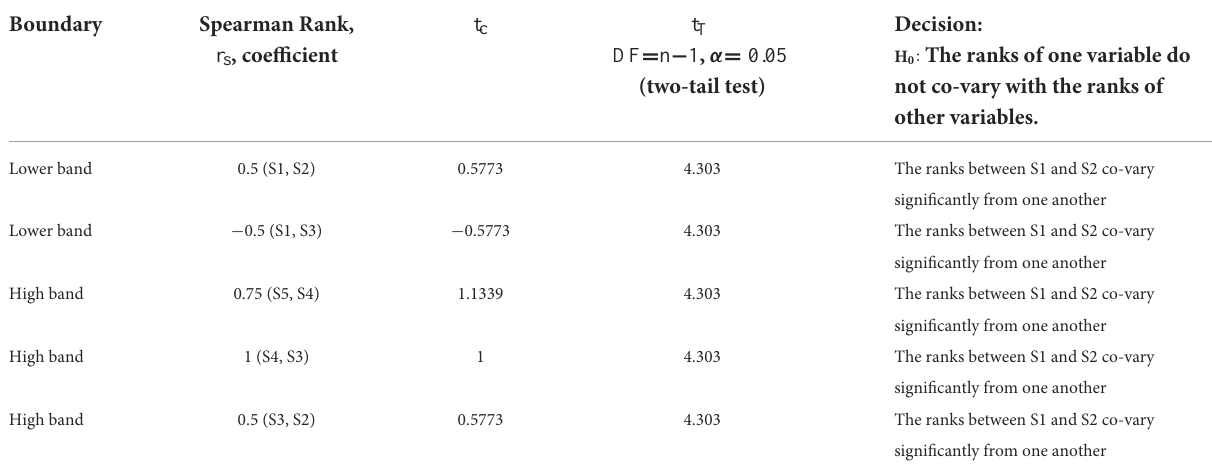
TABLE 11 Spearman Rank test and the t -test of significance.